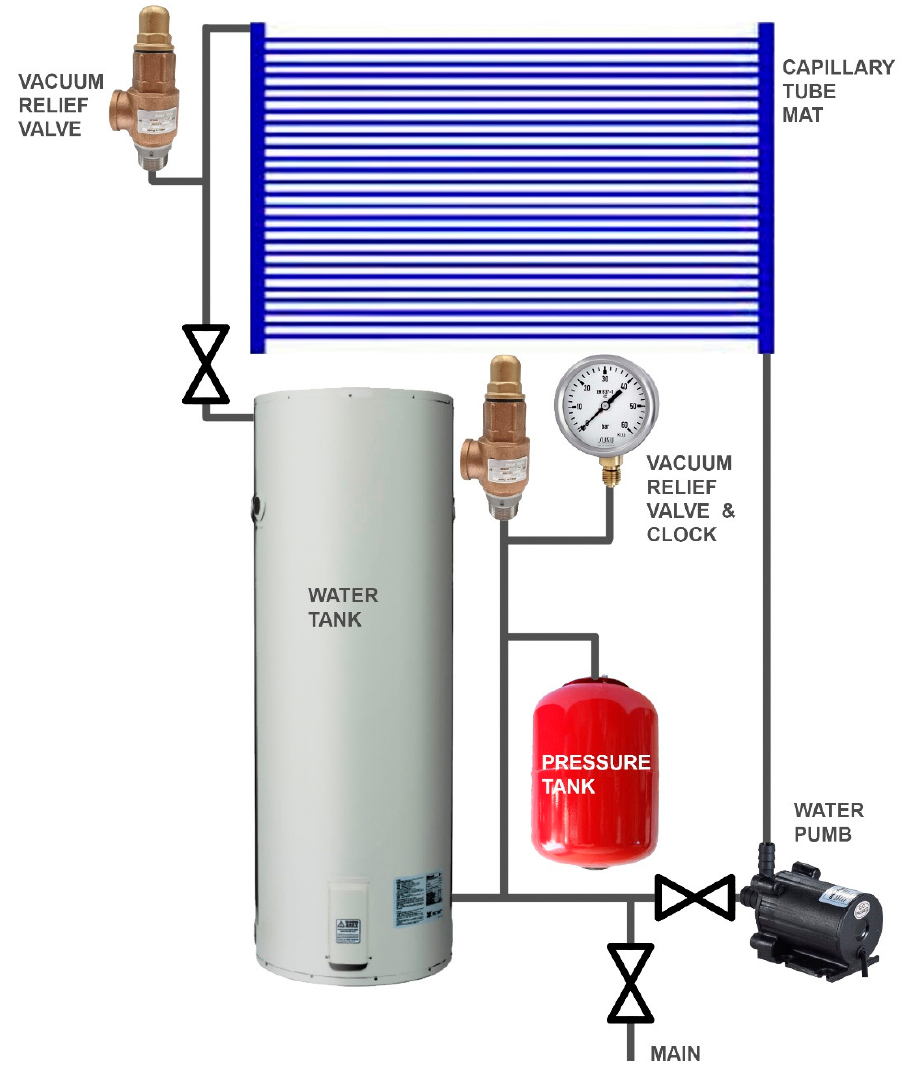
Figure 12. Capillary radiant panel system diagram. Source: KPW Solutions.